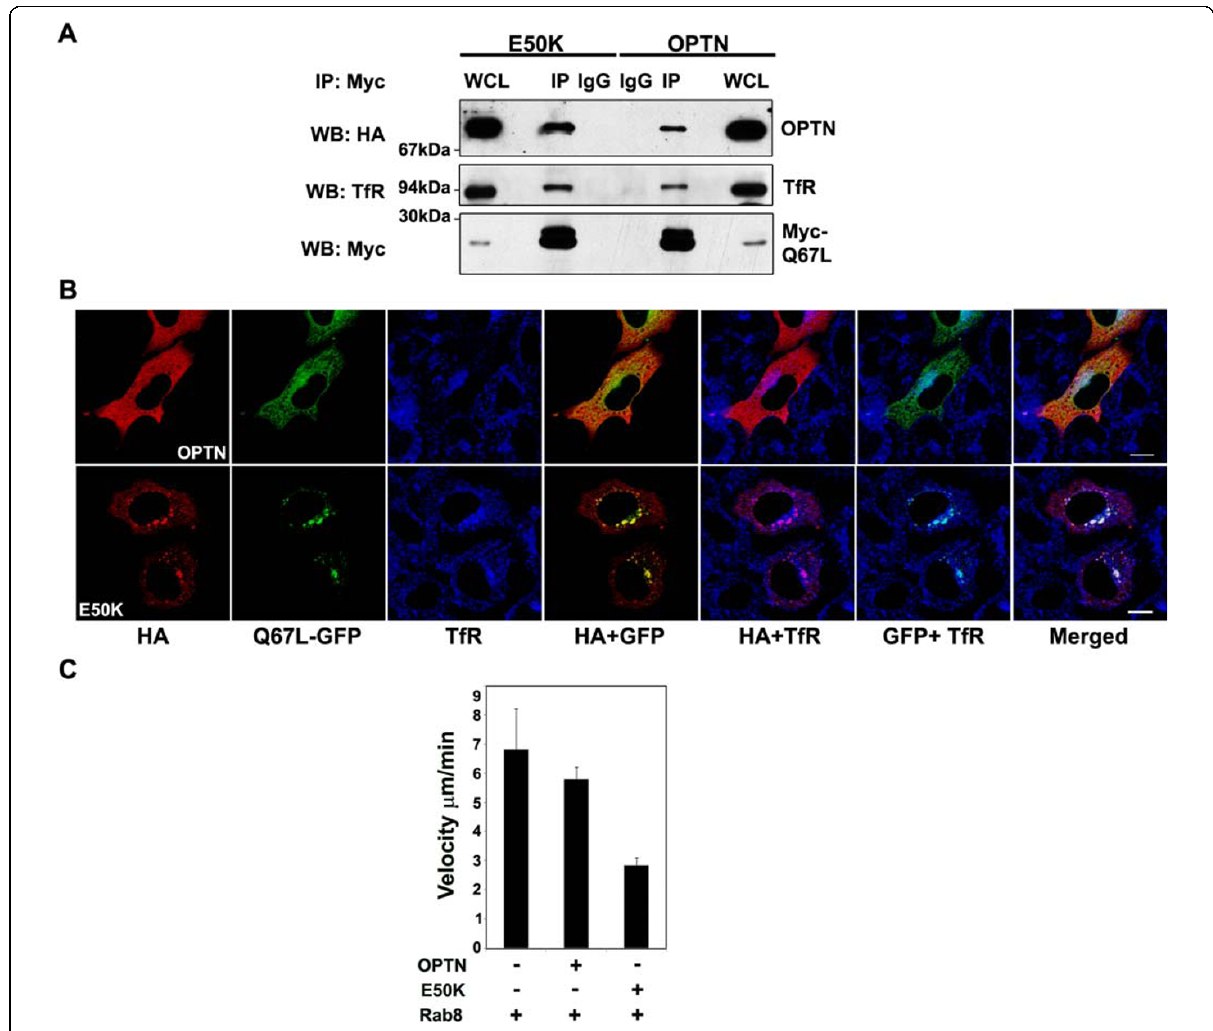
Figure 11 The E50K mutant is altered in its interaction with Rab8 . (A) E50K mutant shows enhanced interaction with activated Rab8. HeLa cells were infected with adenoviruses expressing HA-E50K or HA-optineurin and then transfected with Myc-Q67L-Rab8 mutant. After 36 hrs of infection, lysates were prepared and immunoprecipitated with anti-Myc or control antibody and subjected to Western blotting with TfR, HA and anti-Myc antibodies. WCL, 5% whole cell lysate. (B) Co-localization of E50K mutant with Q67L-Rab8 and TfR. HeLa cells were cotransfected with GFP-tagged Q67L-Rab8 along with HA- tagged E50K mutant or wild type optineurin. Cells were stained sequentially with antibodies against HA- tag (red) and transferrin receptor (blue). Pairwise colocalizations are shown as indicated. Bar; 10 μ m. (C) E50K mutant affects velocity of Rab8 vesicles. HeLa cells were co-transfected with HA-E50K or HA-optineurin and GFP-Rab8 and the movement of Rab8 vesicles was tracked to measure their velocities. In cells co-expressing E50K velocity of Rab8 vesicles is reduced compared to those expressing wild type optineurin or Rab8 alone.